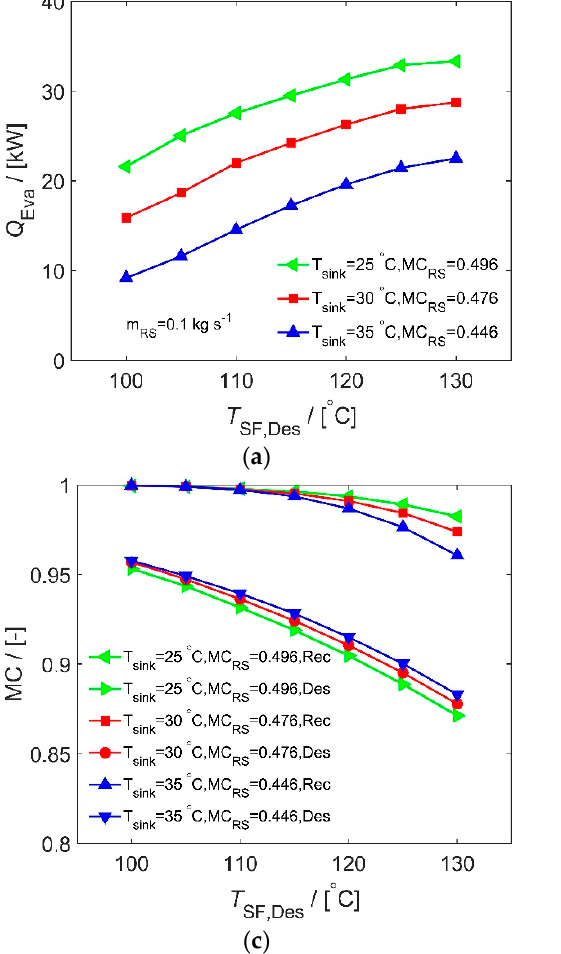
Figure 16. Cycle performances as a function of heat source temperature and heat sink temperature. Cycle performances are ( a ) Cooling capacity, ( b ) Refrigerant mass flow rate, ( c ) Vapour mass concentration at the outlet of the desorber and rectifier, ( d ) COP.